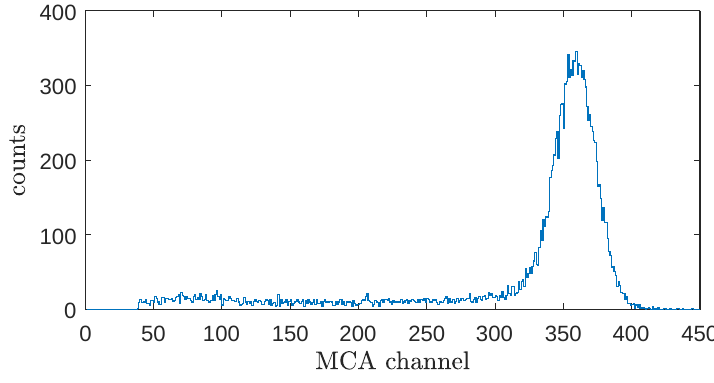
Figure 4 . Pulse-height distribution for 5.9-keV x-rays absorbed in the GPSC active volume (cid:12)lled with Xe-15% He, for a reduced electric (cid:12)eld of 2.4